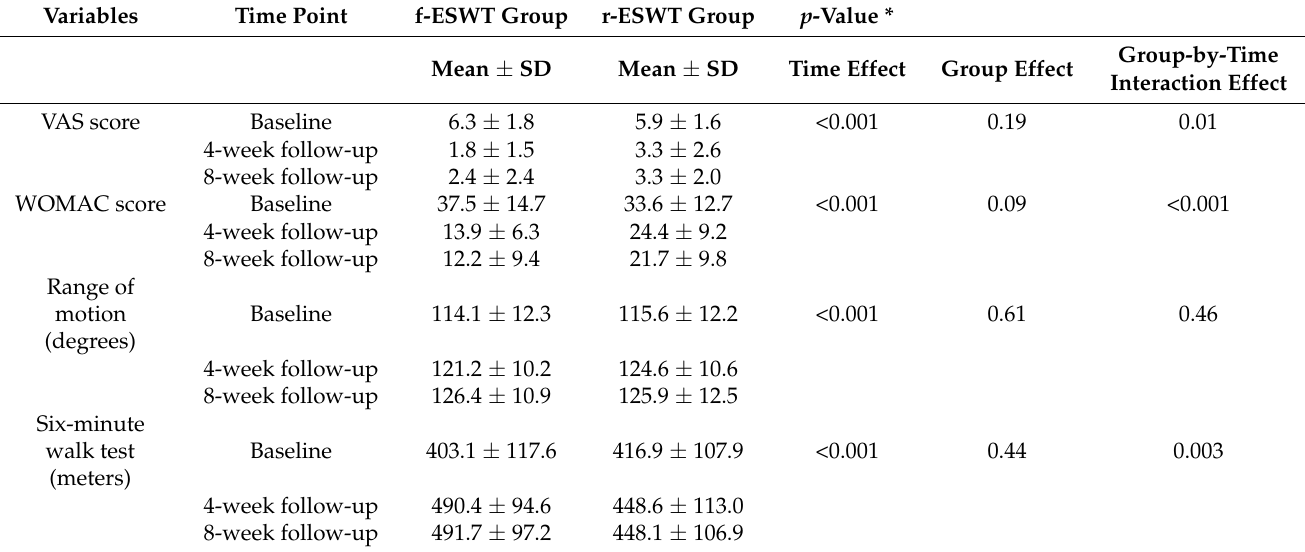
Table 2. Outcome variables at baseline and each follow-up assessment for both groups.